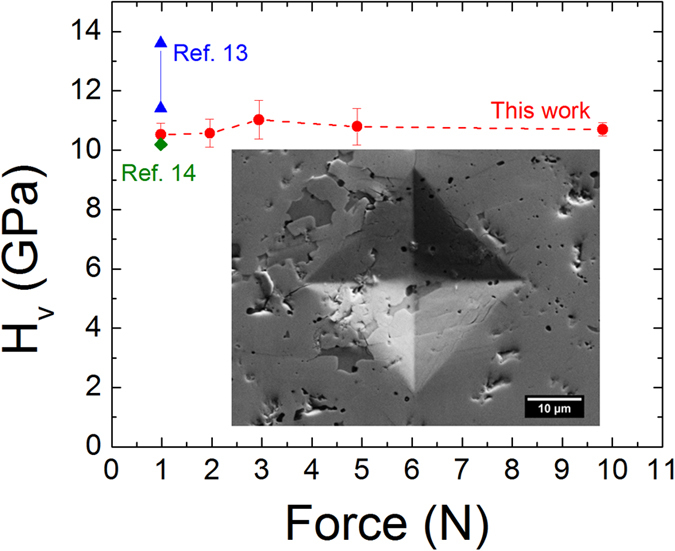
Vickers microindentation hardness as a function of indentation load. Inset shows indent formed under a 9.8 N load. Single crystal hardness values are shown for comparison1314.